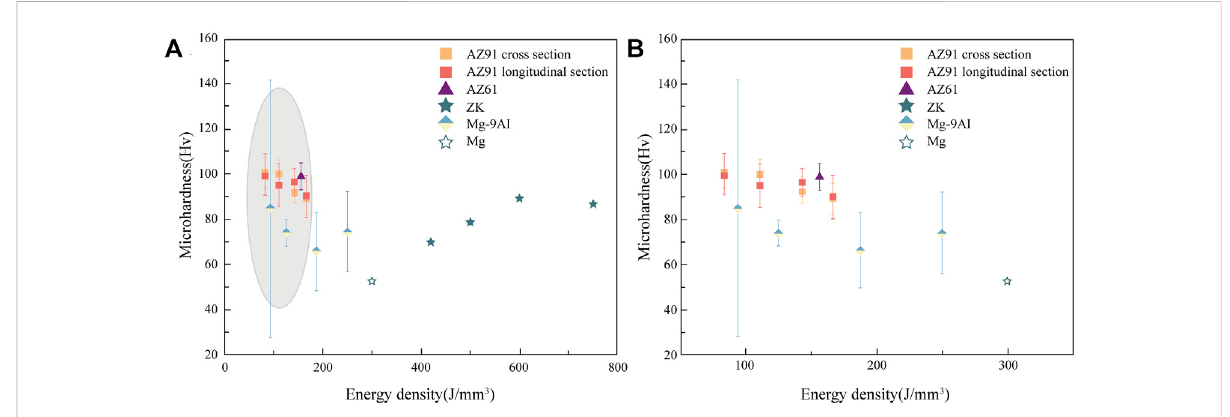
FIGURE 5 Theeffectofenergydensity onthemicrohardnessofL-PBF Mgalloys(LiuandGuo,2020) (A) Effectofenergydensity onthemicrohardness (B) Enlarged image of the grey area in the effect of energy density on the microhardness of L-PBF Mg